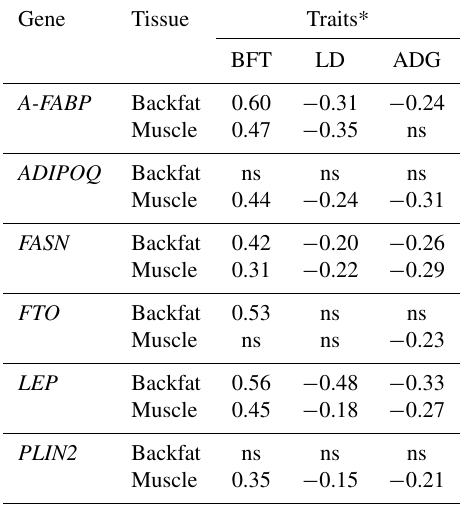
Table 4. Correlations between gene expression and production traits of the experimental